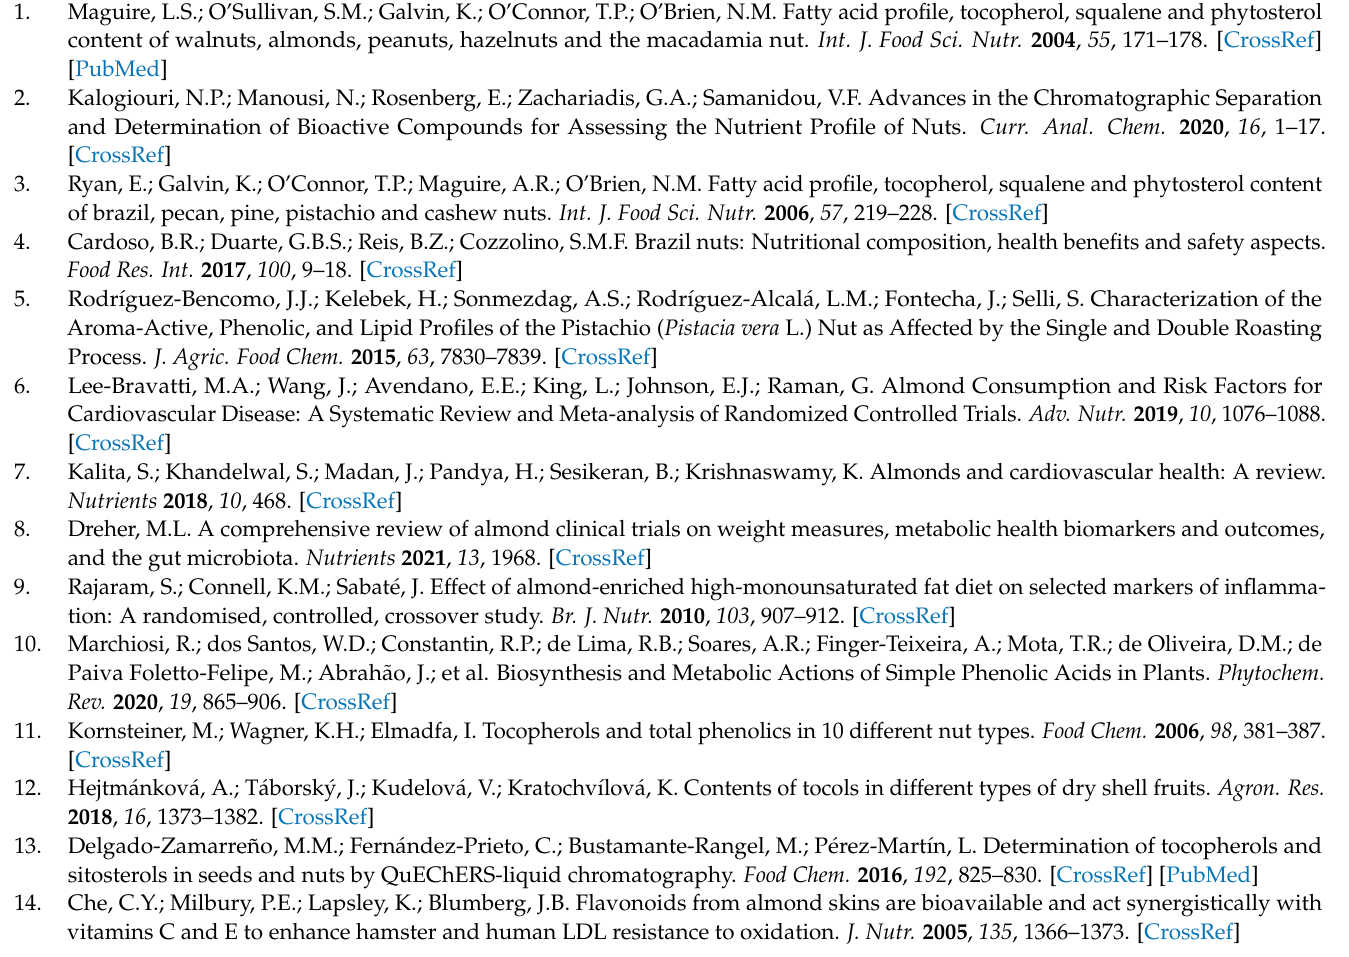
Table S4: Recoveries (%R) for the evaluation of repeatability. Table S5: Recoveries (%R) for the evaluation of repeatability. Table S6: Recoveries (%R) for the evaluation of intermediate precision. Table S7. Chromatographic retention times of the phenolic compounds determined in